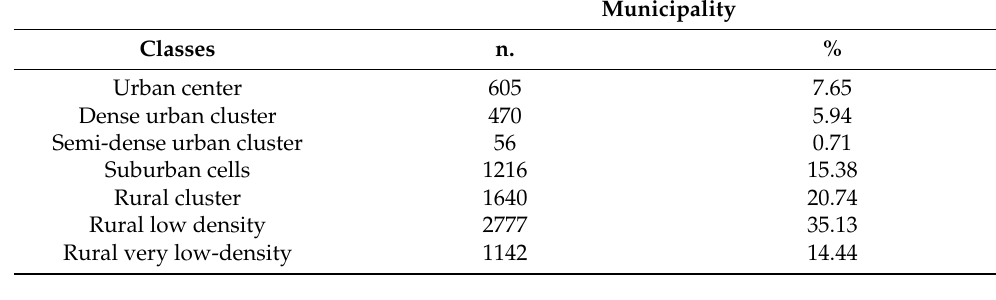
Table 6. Classification of municipalities among the urban–rural classes based on the prevailing class.